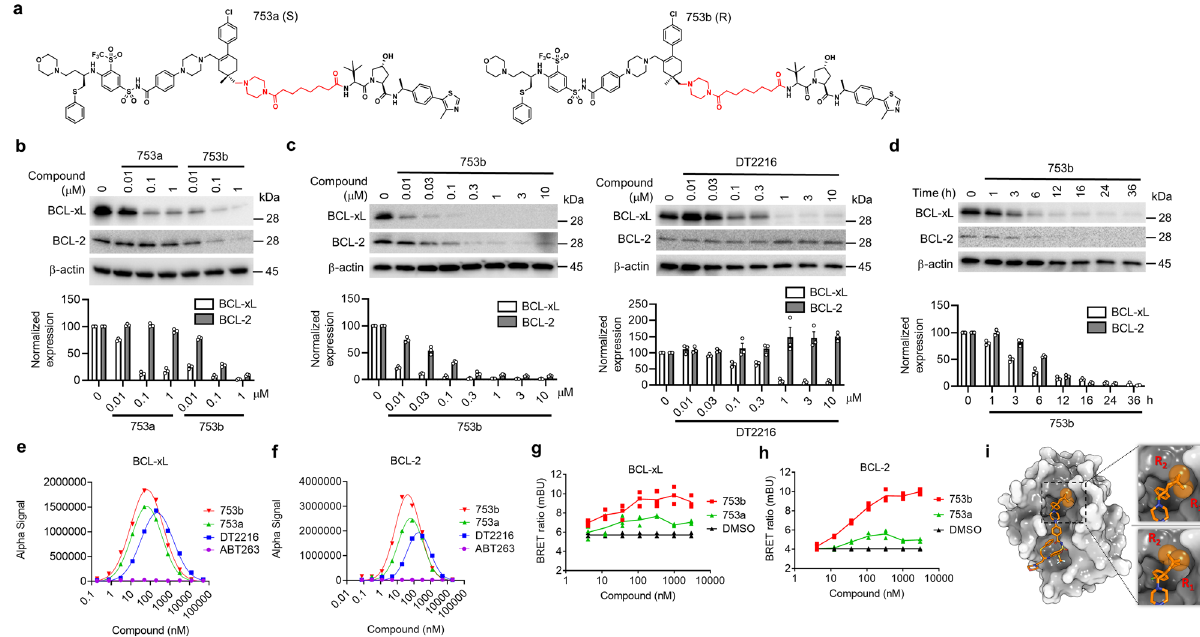
Fig. 3 753b is a dual BCL-xL/2 degrader. a The structure of 753a and 753b. b The potency of 753a and 753b in degrading BCL-xL/2 was evaluated in 293T cells by immunoblots after the cells were treated with different concentrations of 753a or 753b for 16 h. c Comparison of the potencies of 753b and DT2216 in degrading BCL-xL/2 by immunoblots in 293T cells after the cells were treated with different concentrations of 753b or DT2216 for 16 h. d The time course of 753b-mediated BCL-xL/2 degradation was evaluated in 293T cells by immunoblots after the cells were treated with 1 μ M 753b for various time points as indicated. Representative immunoblots are shown in ( a – d ) and β -actin was used as a loading control in all immunoblot analyses. The normalized protein content in the immunoblots is presented as mean values ± s.e.m. ( n = 3 biologically independent experiments) in the bar graph (bottom panel). e , f The formation of BCL-xL/PROTAC/VCB ( e ) and BCL-2/PROTAC/VCB ( f ) ternary complexes in a cell-free condition was determined by AlphaLISA assay. Data represent the mean of a single experiment with 2 technical replicates. Similar results were obtained in one more independent experiment. g , h NanoBRET assays showed that 753b forms more stable ternary complexes with BCL-xL ( g ) and BCL-2 ( h ) in 293T cells compared with 753a. 293T cells were transiently transfected with HiBit-BCL-xL, LgBit, and HaloTag-VHL or HiBit-BCL-2, LgBit, and HaloTag-VHL and then treated with a serial dilution of 753a or 753b for 6 h. Data are expressed as mean of three biological replicates. i The different conformations of linker methyl groups on